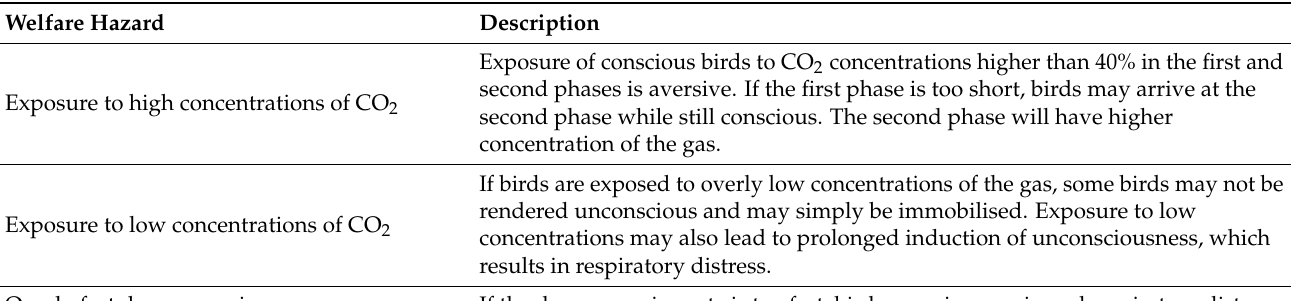
Table 3. Animal welfare hazards associated with the use of controlled atmosphere stunning of birds (descriptions adapted from EFSA